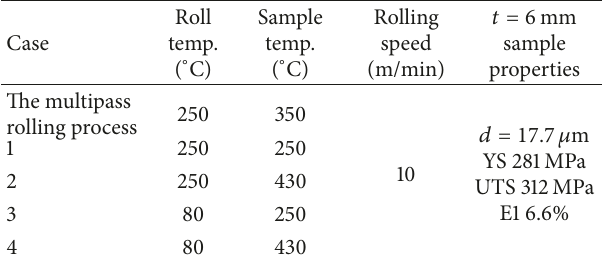
Table 3: Variation in the rolling conditions for samples 6–3 mm in thickness. The mechanical properties and mean grain size of the 6 mm thick alloy are